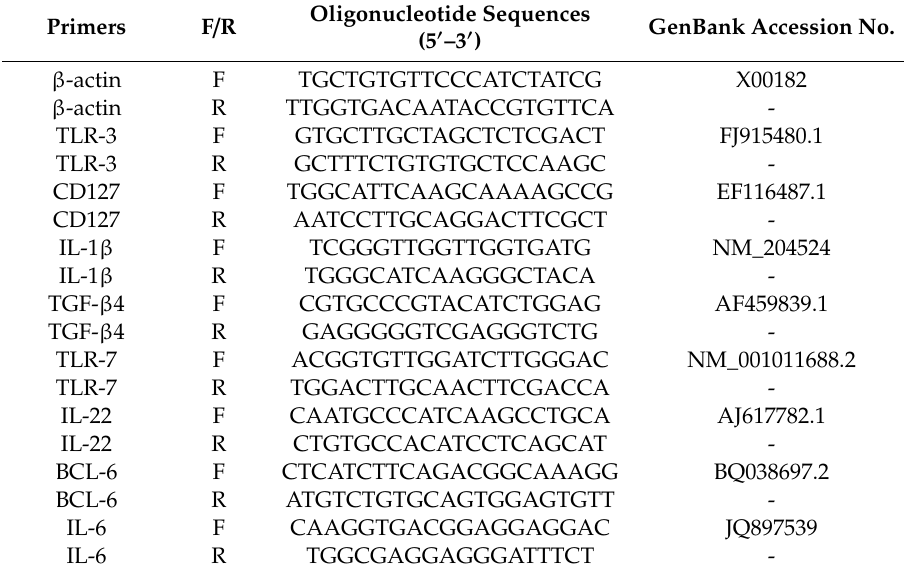
Table 1. The primers for quantitative real-time polymerase chain reaction (qRT-PCR). Oligonucleotide Sequences Primers F / R GenBank Accession (5 (cid:48) –3 (cid:48) )